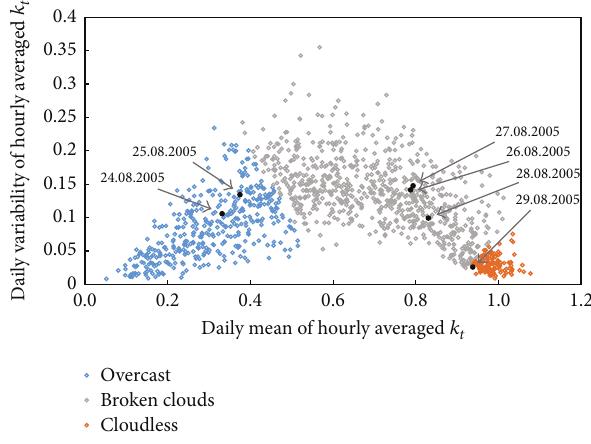
Figure 4: Visualization of the classification of weather conditions by 𝑘 𝑡 patterns using measurement values from Lindenberg, Germany. with only little daily Cloudless days feature high daily means 𝑘 𝑡, day ̃𝑘 variability 𝑡, day . Days with overcast sky can be characterized by low daily means and low to mid variability. Days with broken clouds feature a high daily variability and mid to high daily means. The black points refer to the example days of Figure